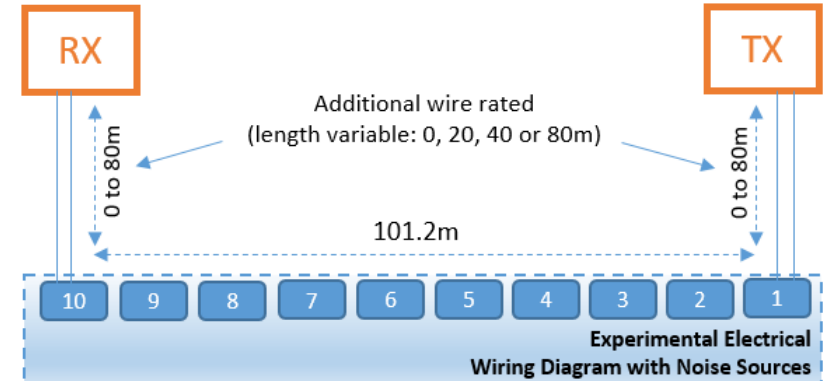
Figure 4. Test Scenario 2: Positioning of noise sources and extension of the distance of the Tx and Rx modems in lengths from 20 to 80 m.